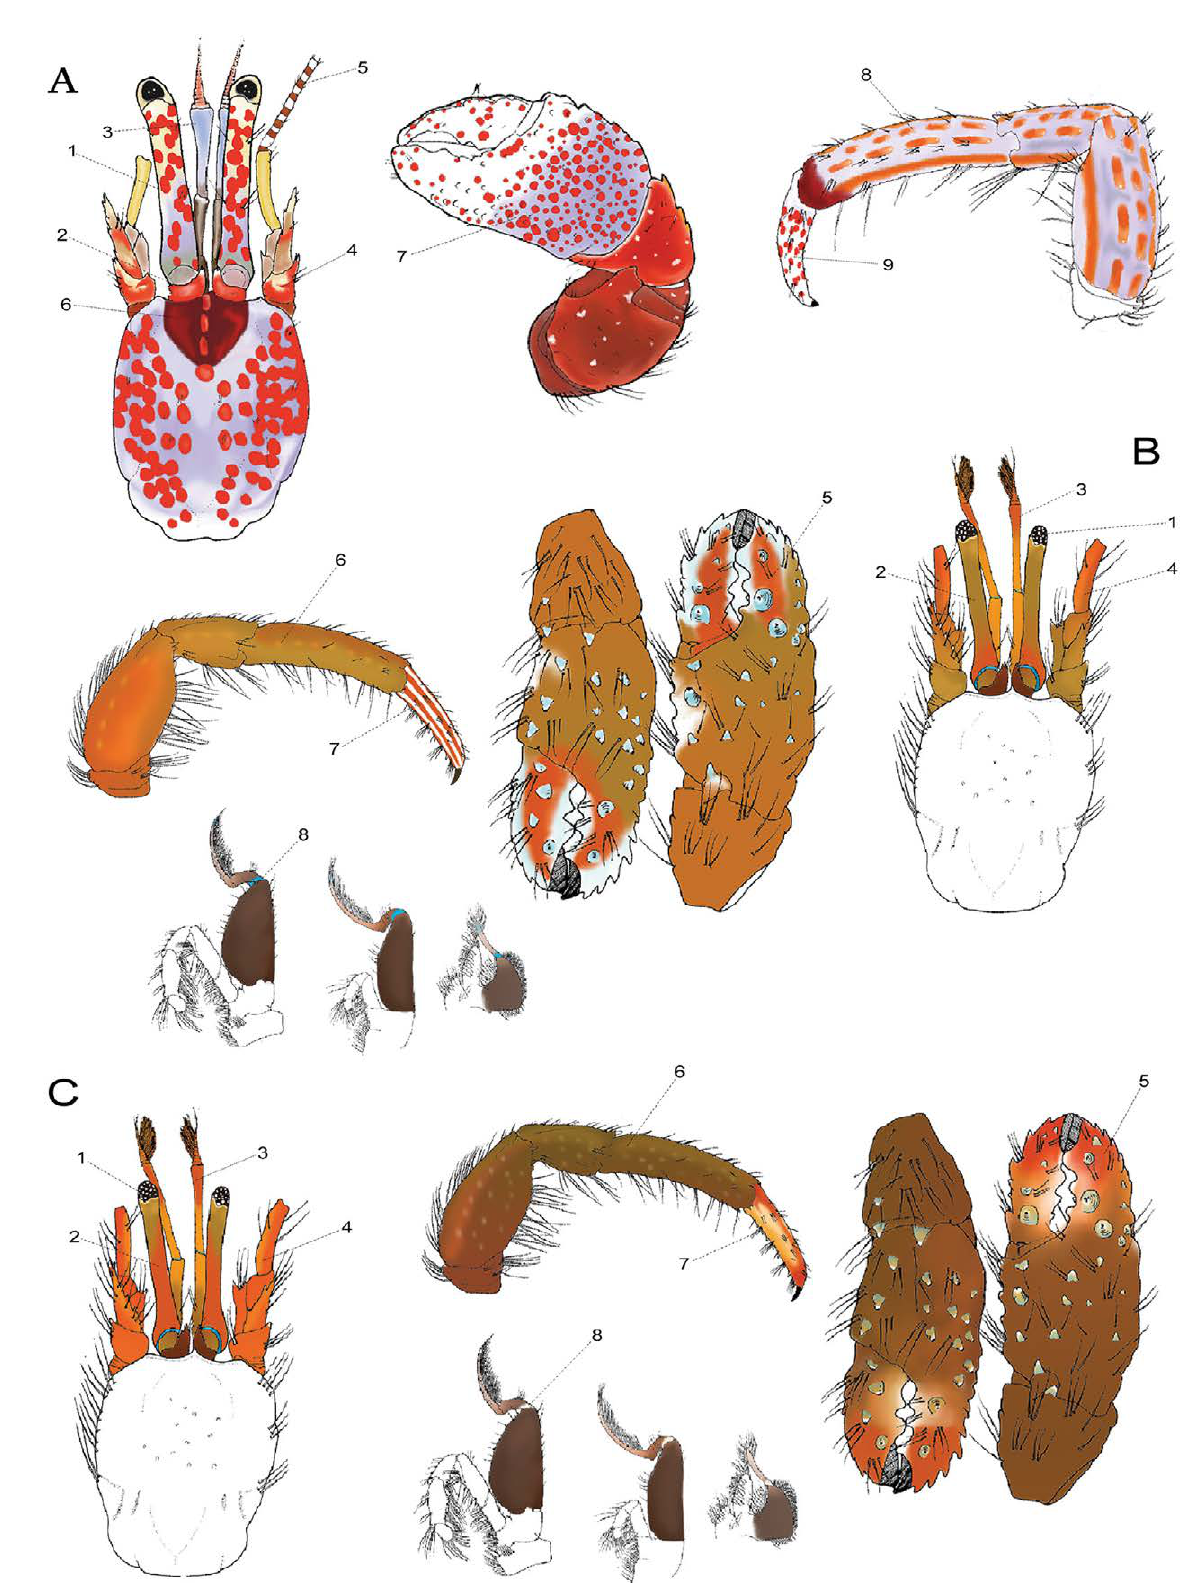
Fig. 1. – Colour patterns of the Diogenidae species: Calcinus tubularis (A, 1-9); Clibanarius erythropus (B, 1-8); Clibanarius aequabilis (C, 1-8). All vectorial drawings modified from Ingle